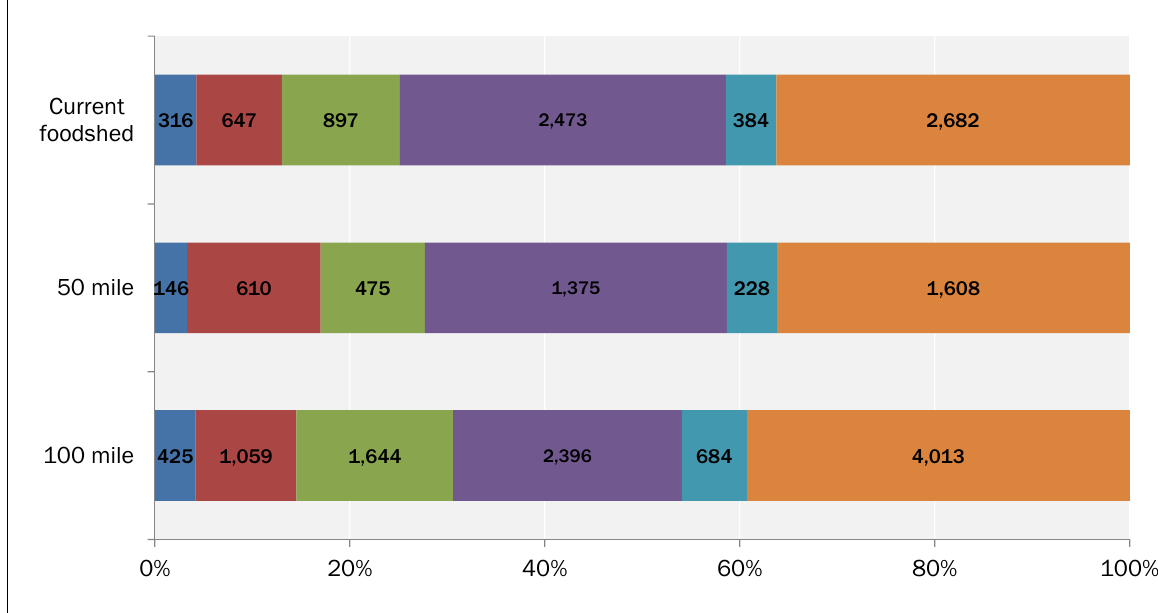
Figure 5. Food Production by Food Group The proportion of food produced in each food group for three foodshed regions. Percentages based on production (in tons) out of total production in each foodshed. Numbers inside the bars represent actual production in 1,000